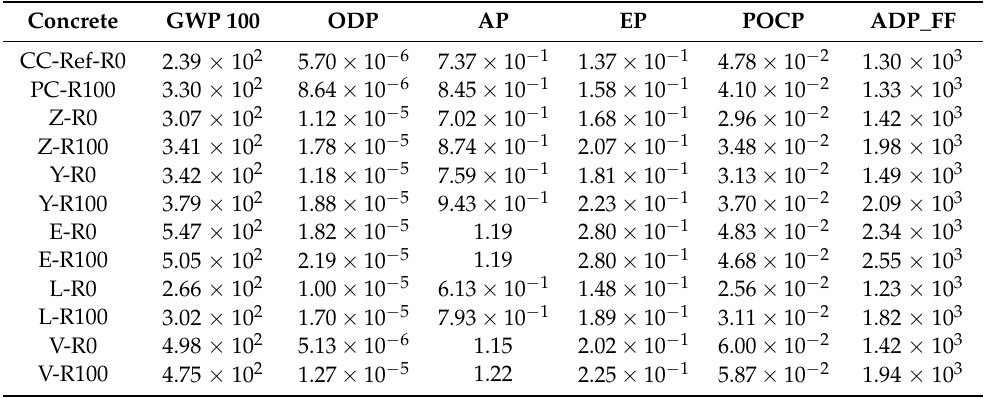
Table 12. Values obtained for the different environmental impact indicators for each concrete formulation in scenario 1.